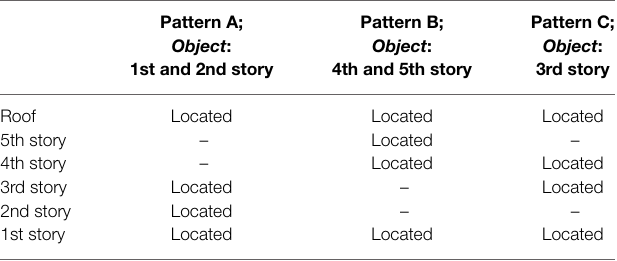
! u are the lower and upper cut-off frequencies in the band-pass TABLE 1 | Location of velocity meter and measurement pattern for stiffness identification